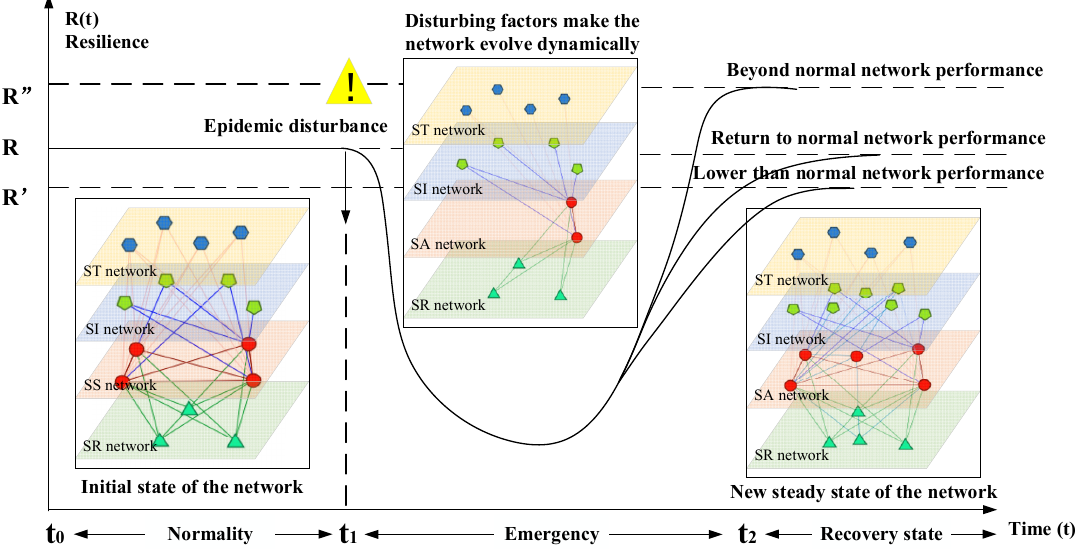
Figure 3. Schematic diagram of the dynamic network disturbance mechanism of urban community anti-epidemic.